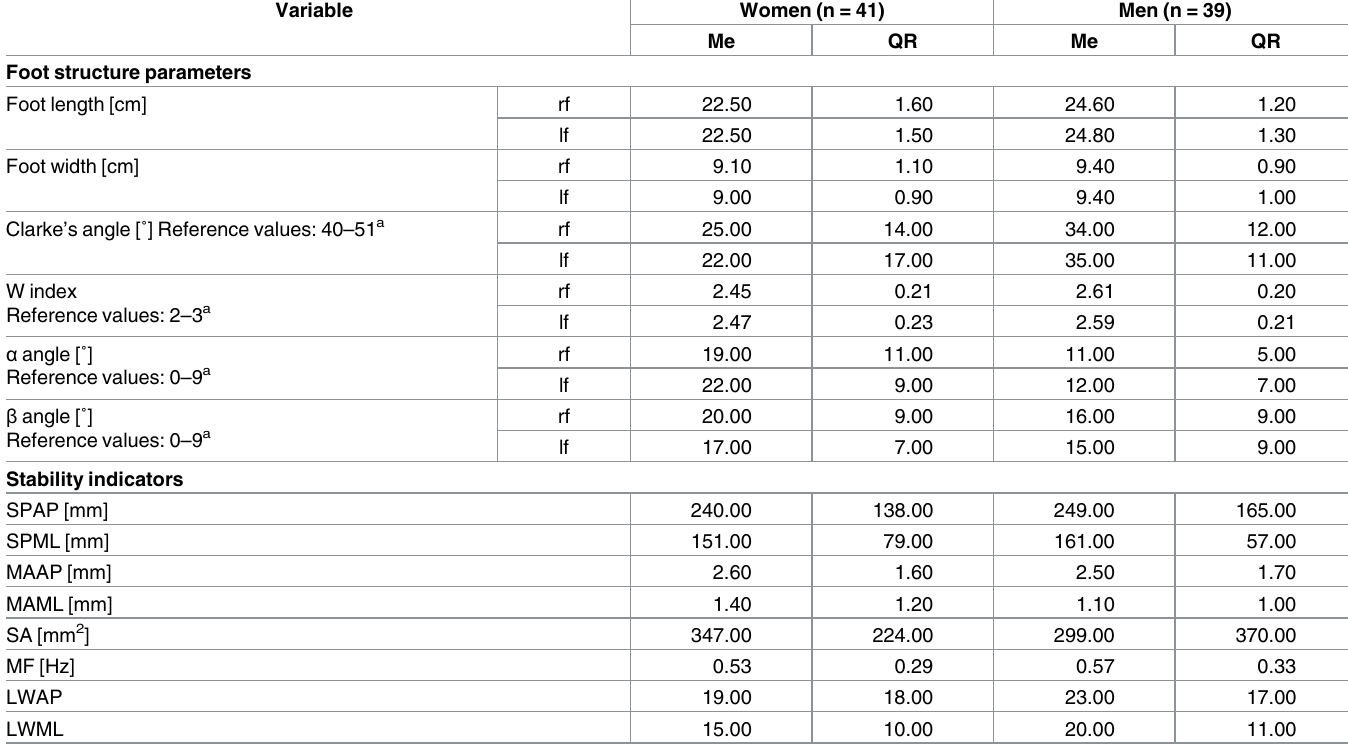
Table 2. Descriptivestatistics of structural features of the feet and the stability indicators in the study subjects.